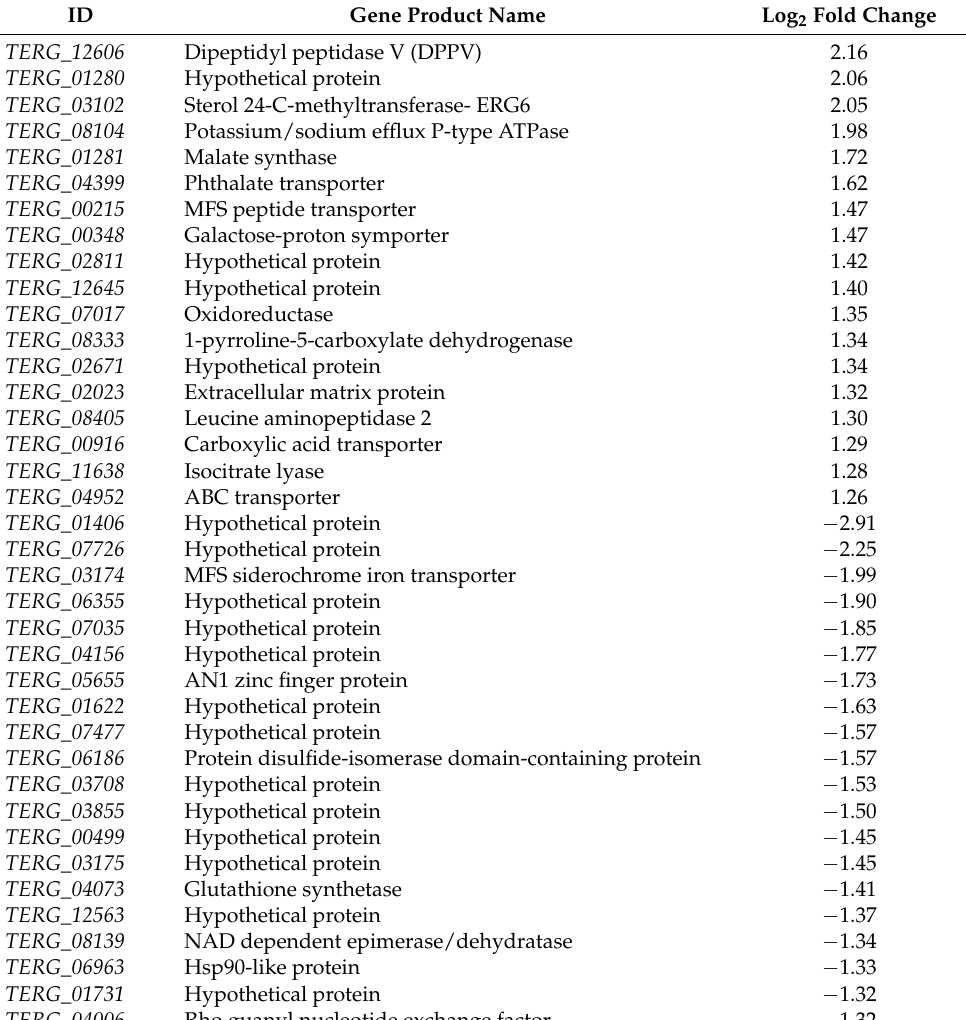
Table 2. The major up- and down-regulated genes in T. rubrum after 24 h of